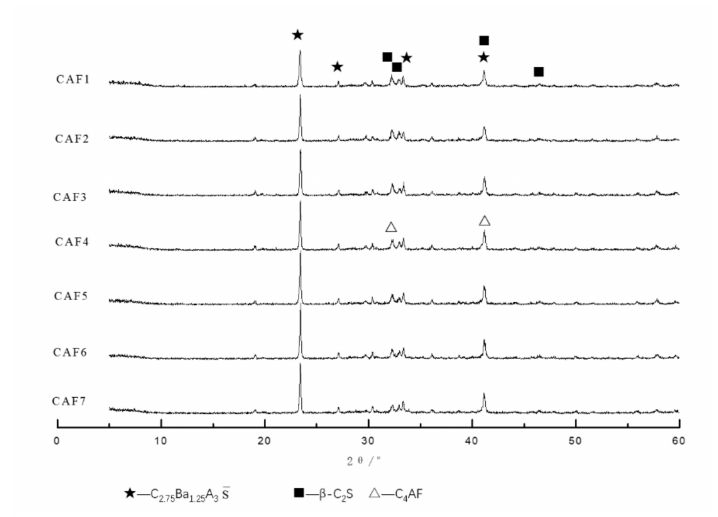
Figure 2. XRD patterns of different clinkers at 1350 ◦